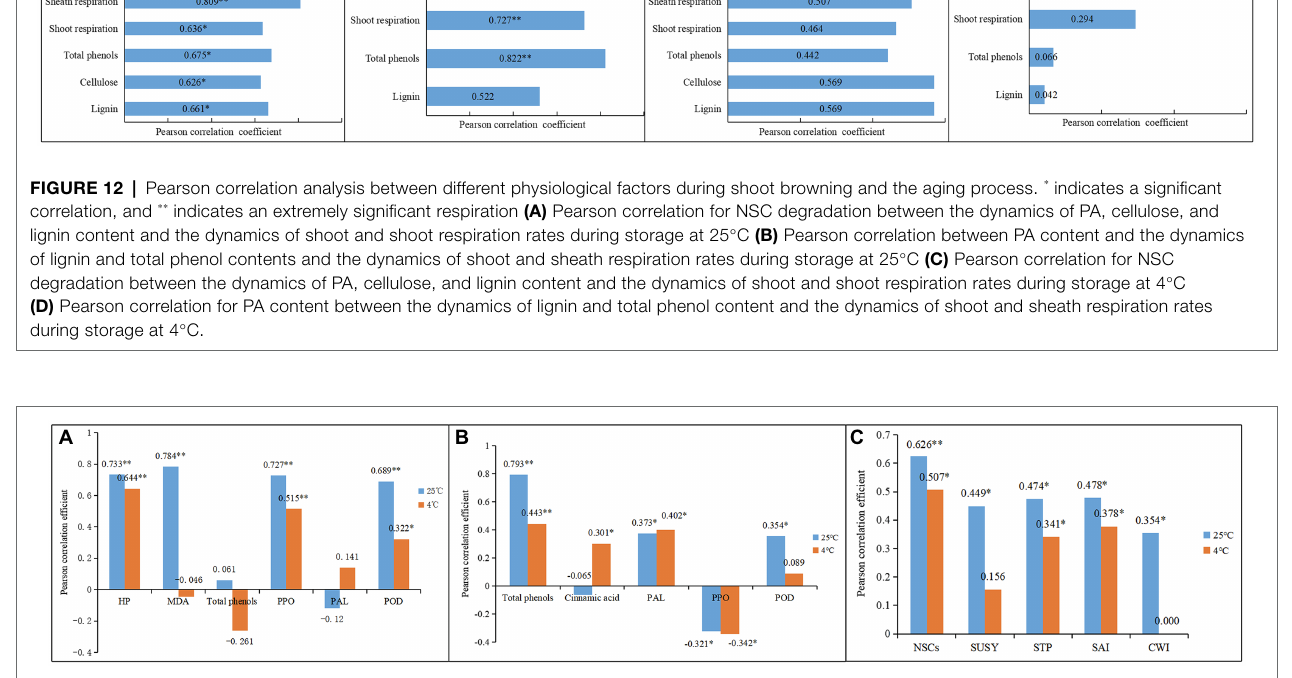
FIGURE 13 | Pearson correlation analysis of the physiological indexes between different storage conditions. * Indicates a significant correlation, and ** indicates extremely significant respiration (A) Pearson correlation among the substances of browning (B) Pearson correlation among the substances of lignification. (C) Pearson correlation among the substances of